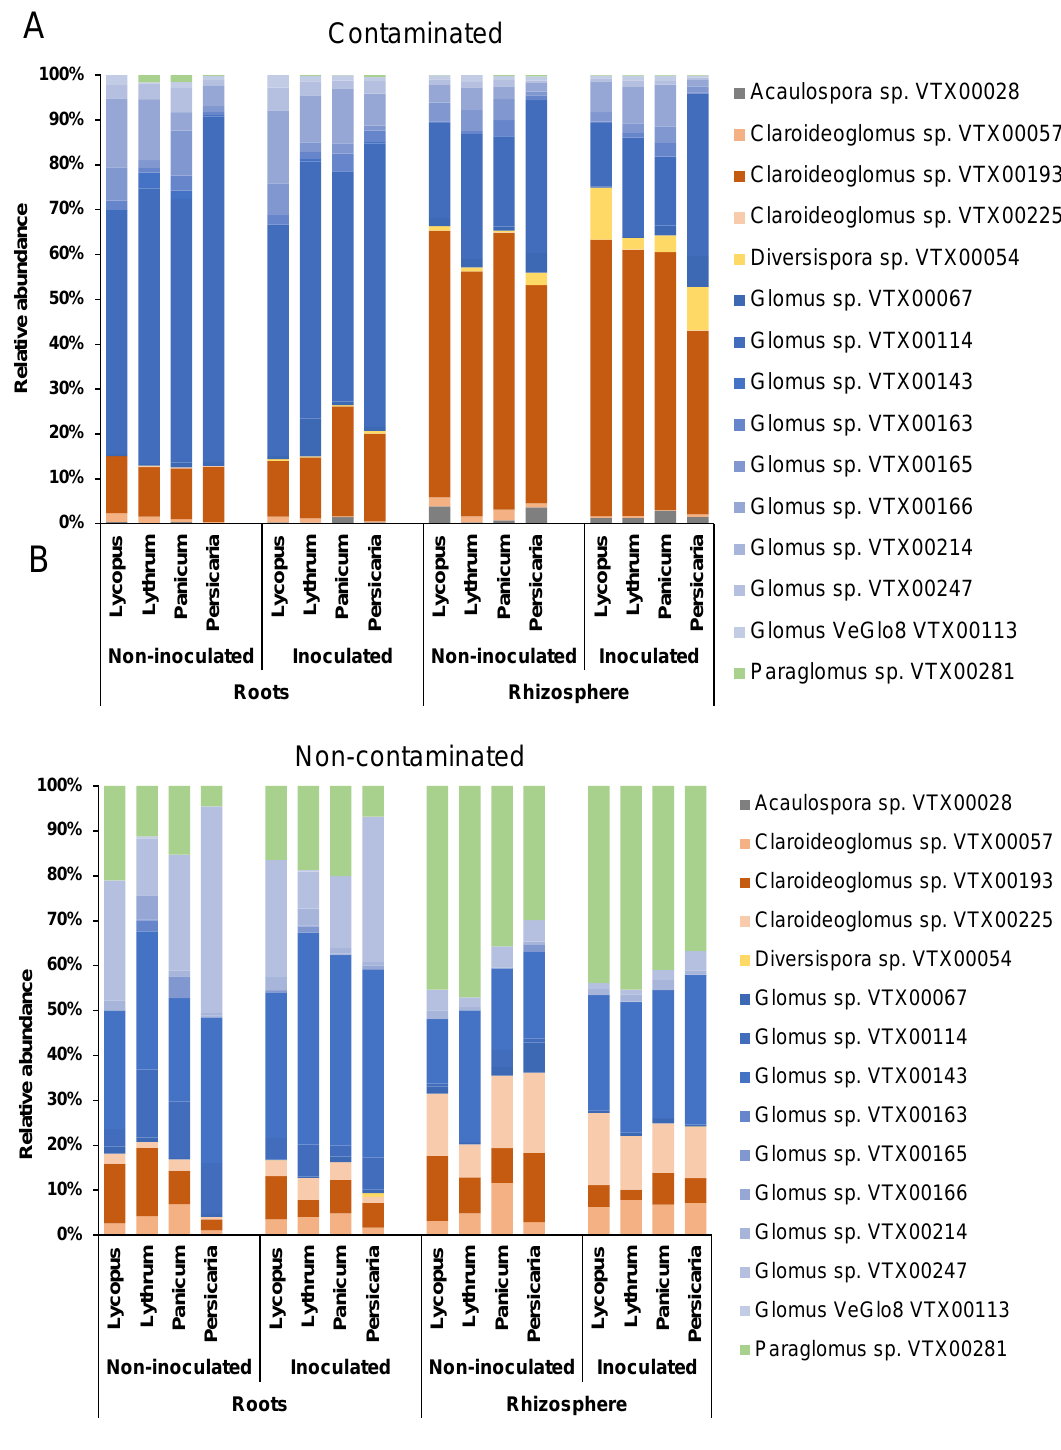
Figure 1. Relative abundance of AMF taxa detected in the roots and rhizospheres of plants from the contaminated substrate ( A ) and the non-contaminated substrate ( B ) , inoculated or not-inoculated with the bacterial consortium. LE: Lycopus europaeus ; LS: Lythrum salicaria ; PC: Panicum capillare ; PL: Persicaria lapathifolia .